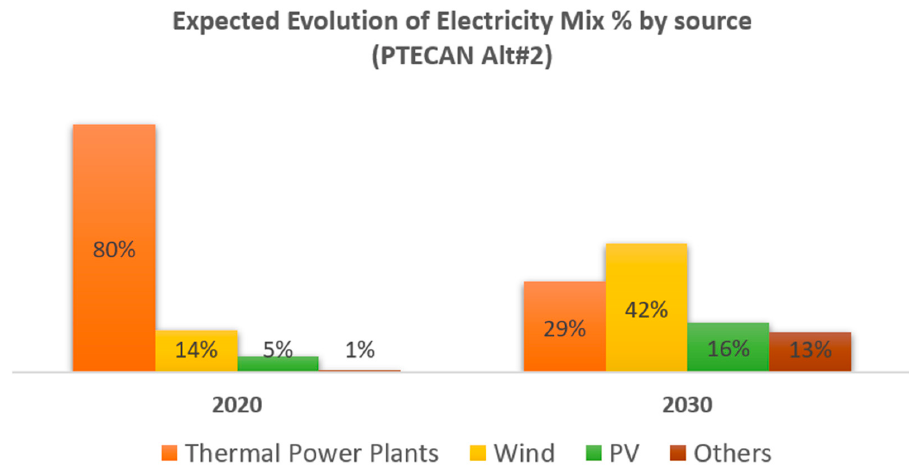
Figure 7. Expected evolution of electricity mix by weight in percentage. Source: Own elaboration sourced with the Canary Islands Yearbook and PTECAN.